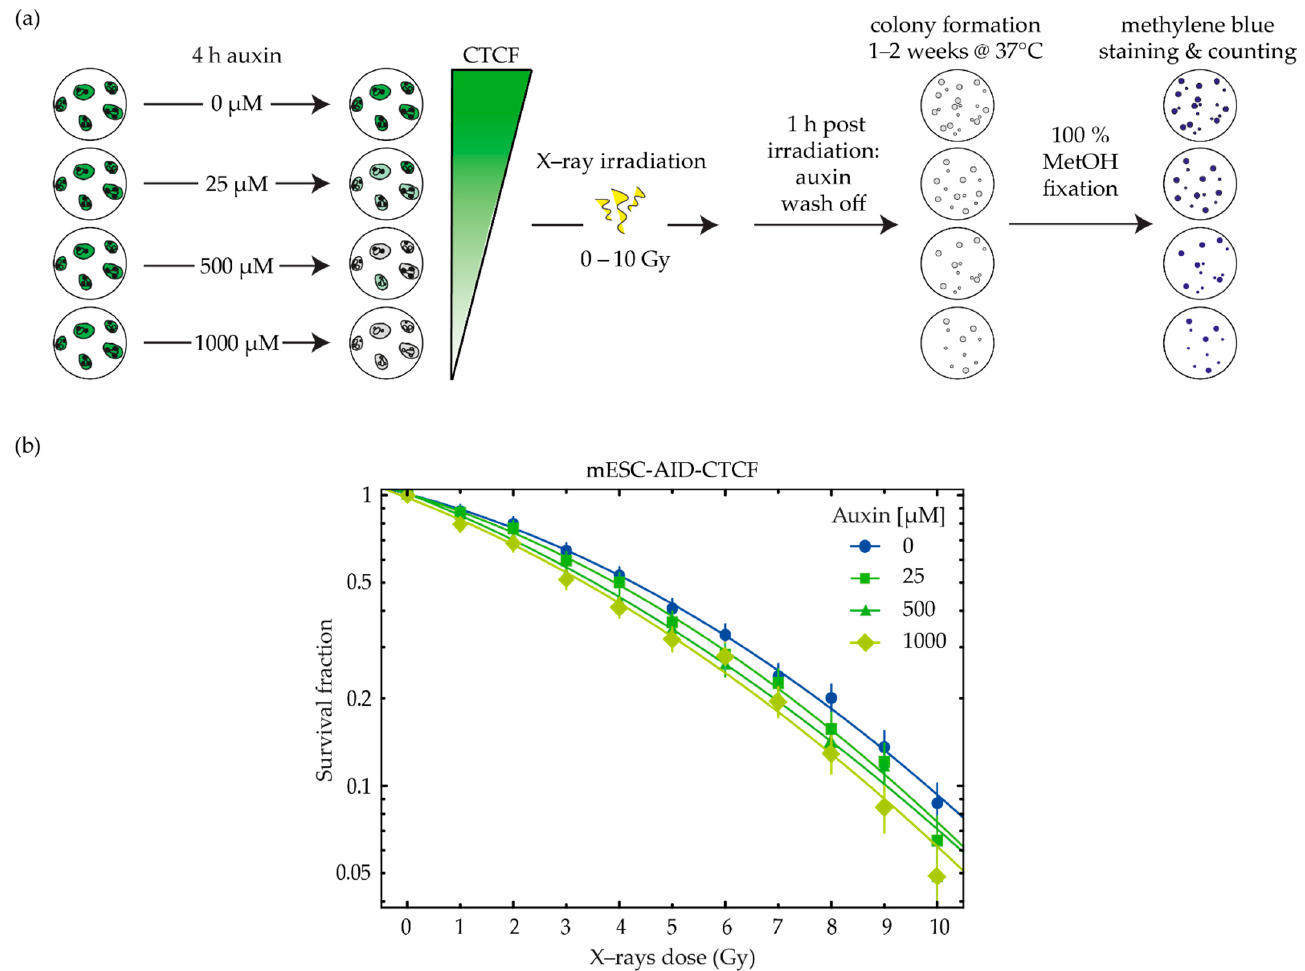
Figure 8. Clonogenic assay of mESC-AID-CTCF cells upon auxin-induced CTCF depletion and irradiation. ( a ) Auxin treatment was applied for 4 h (0, 25, 500, 1000 µM) after single-cell seeding, at which time point cells were irradiated with X-rays (0–10 Gy); 1 h after irradiation, auxin was washed off and single cells were allowed to form colonies for 7–10 days under standard culture conditions. Colonies were then fixed with cold 100% methanol and stained with methylene blue. The colonies with more than 50 cells were microscopically identified and counted by eye; ( b ) Each data point was normalized to the average of the respective unirradiated control and plotted as relative survival fractions in a semi-logarithmic scale with a linear-quadratic dose–response curve fitting (whiskers = error bars; fit weighted by 1 ). The results consist of four biological replicates (Table